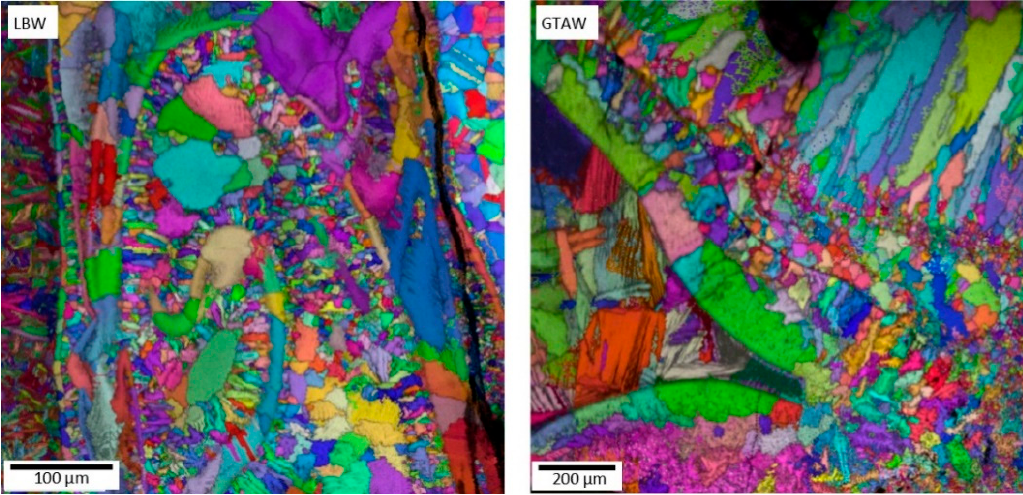
Figure 9. Corresponding EBSD inverse pole figure (IPF) maps with IQ overlay from Figure 8.